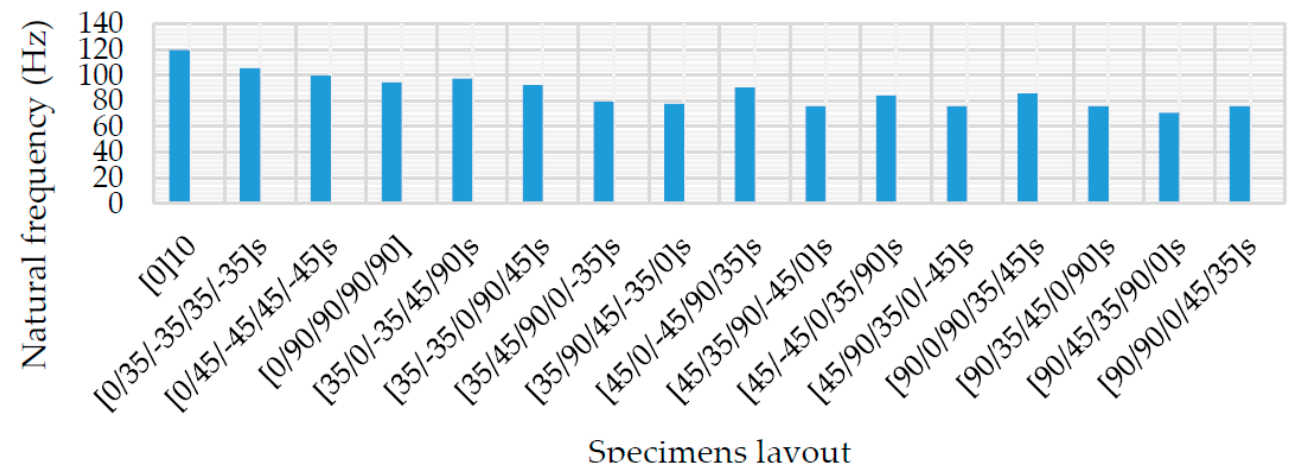
Figure 4. Variation of natural frequencies with stacking sequences and fiber orientations.